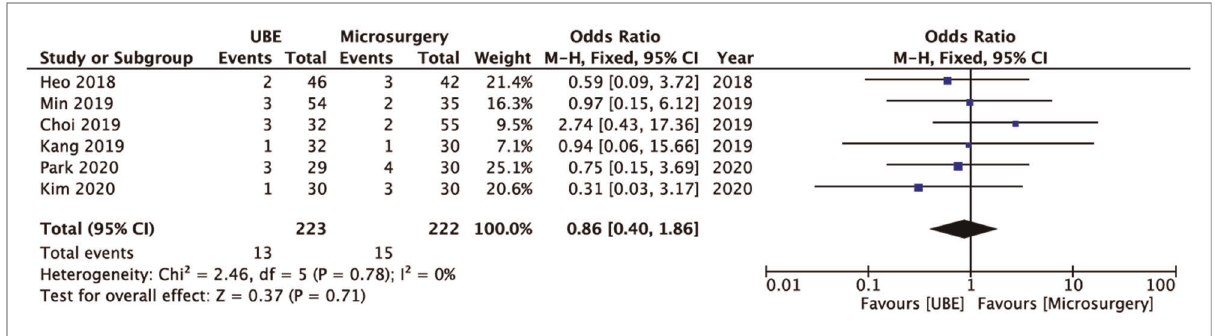
FIGURE 10 Forest plot for comparions of complications between between UBE ULBD and microscopic ULBD. UBE, unilateral biportal endoscopic; ULBD, unilateral laminectomy with bilateral decompression.